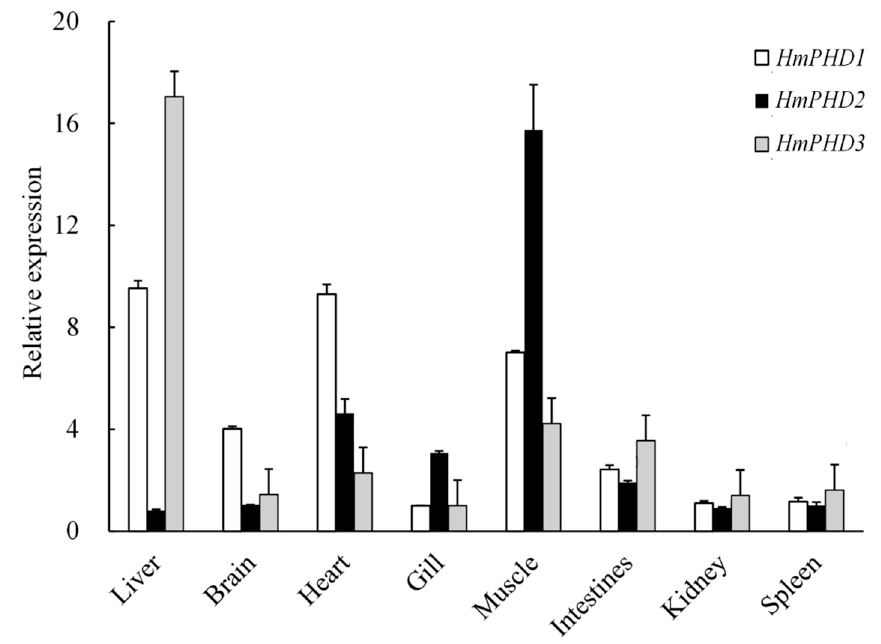
Figure 3. Tissue distributions of the transcripts of PHD genes in H. molitrix with β -actin as the positive control. Data were shown as mean ± SE ( n = 3).